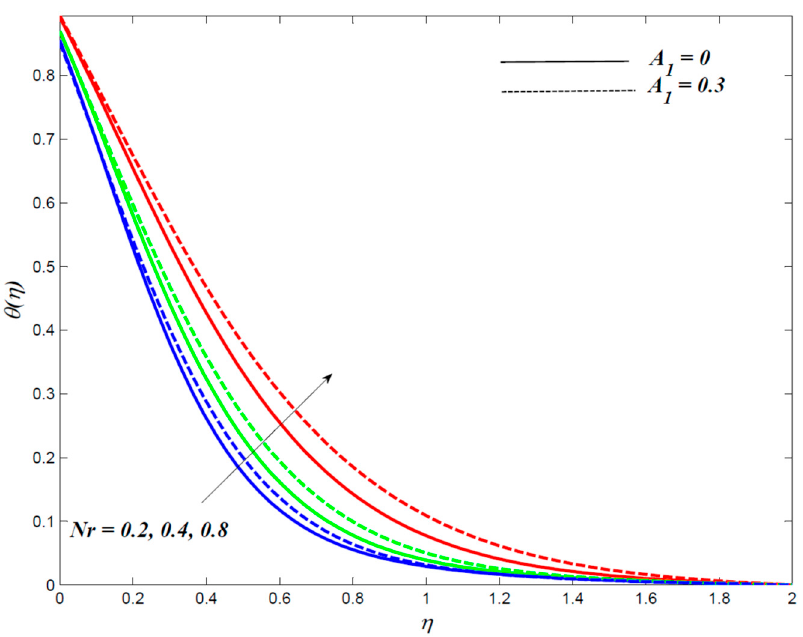
Figure 7. Temperature profiles owing to varying values of Nr .